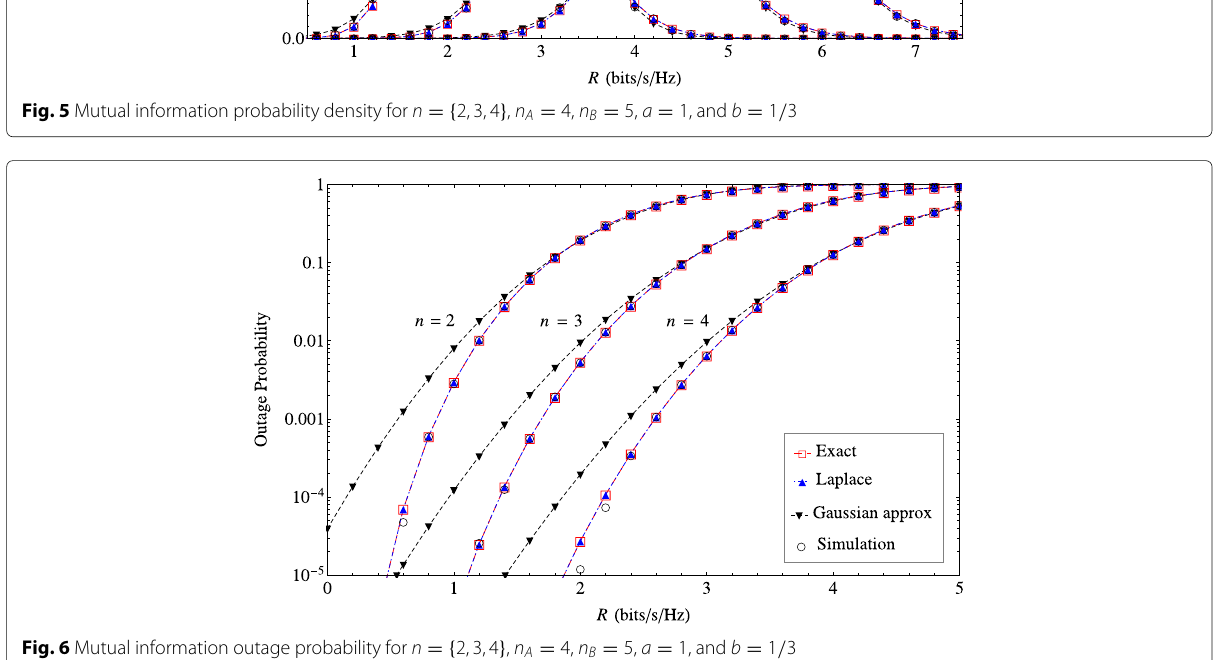
Fig. 6 Mutual information outage probability for n = { 2,3,4 } , n A = 4, n B = 5, a = 1, and b = 1 / 3